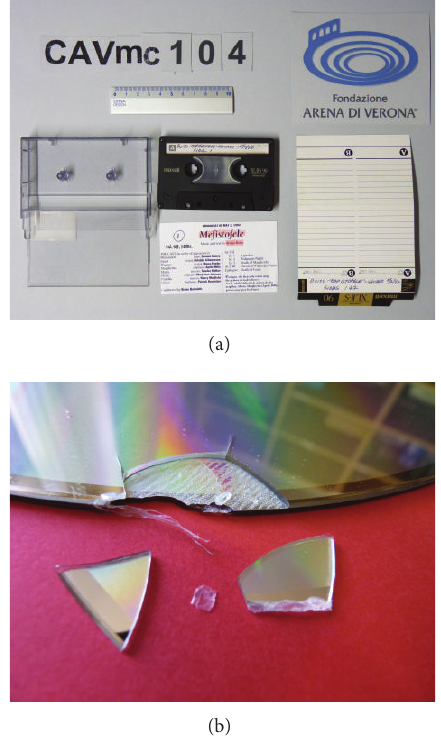
Figure6:(a)Exampleofoneofthesetofimagesincludedinthepre- servation copy of a compact cassette. Each element should be clearly visible in all its details, so usually a preservation copy contains